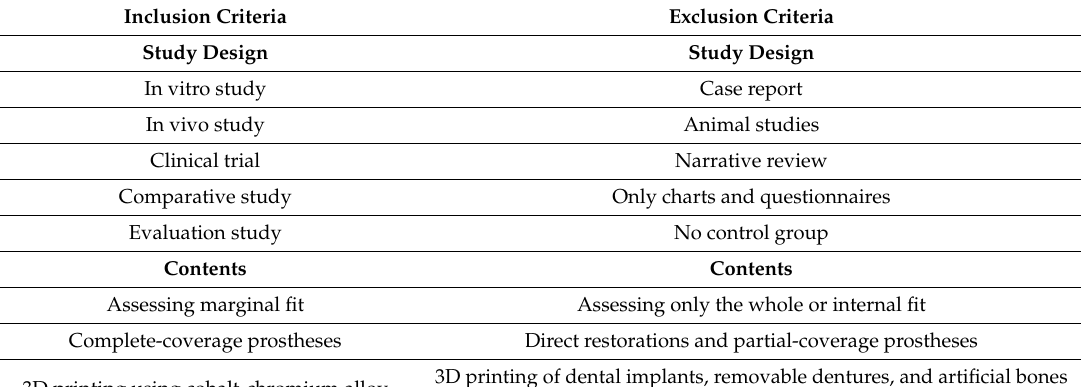
Table 1. Inclusion and exclusion criteria used in the